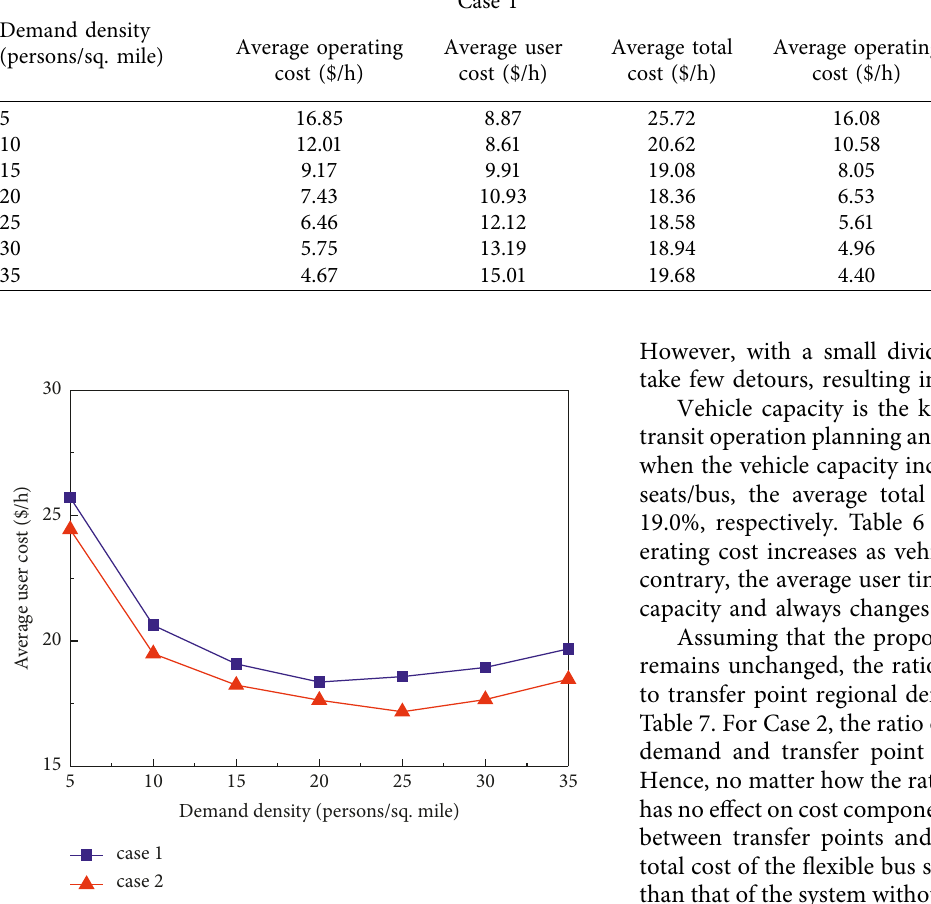
Figure 4: Average total cost variations over demand